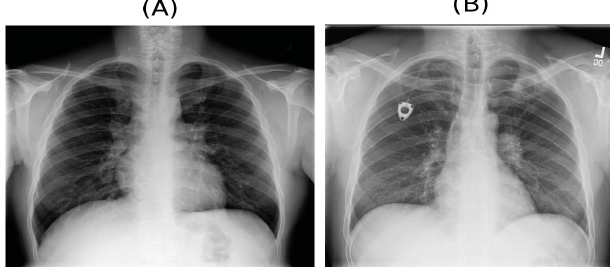
Figure 1 : Sample X-ray image of normal (A) and lung pneumonia (B).